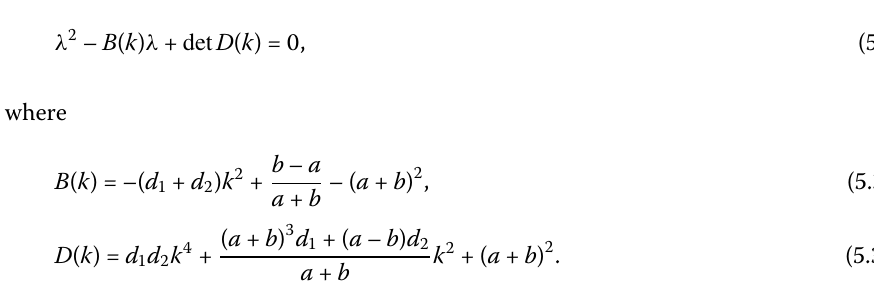
Figure 12 The stability of the spatially homogeneous steady state for (1.3a)-(1.3d) with the first-order derivative and the parameters a = 0.26 and b = 0.6 in region V. Other parameters are as in Figure